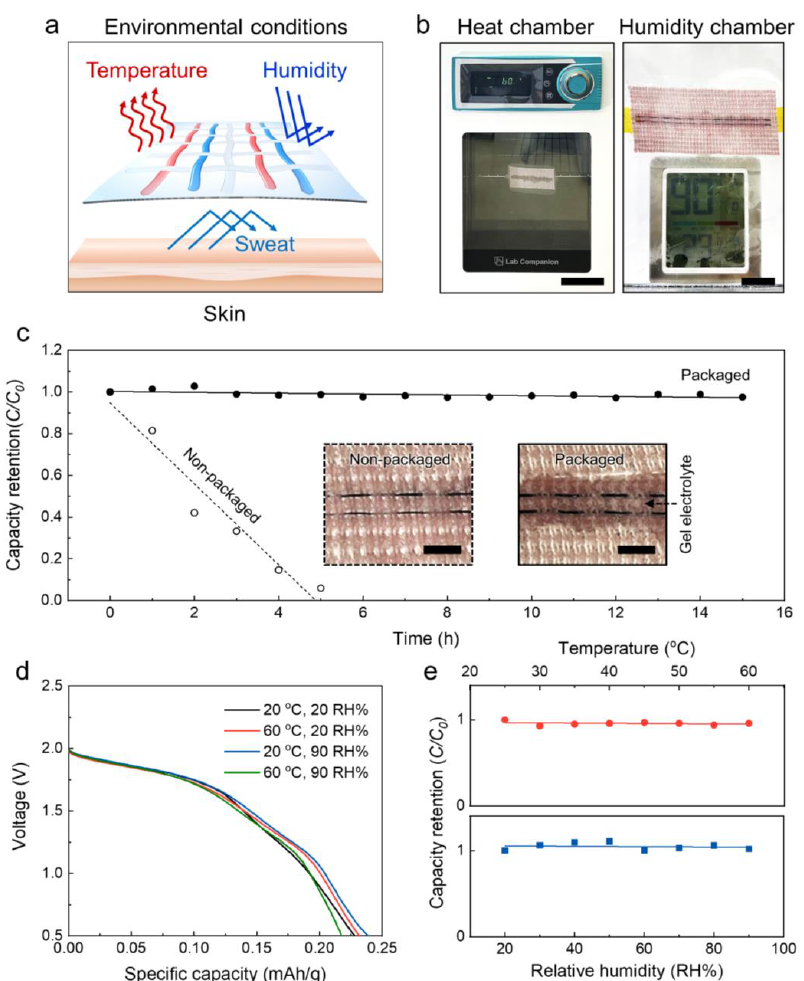
Figure 3. ( a ) Schematic illustration showing the external environmental factors that affect the electrochemical performance of the textile battery. Optical photographs of the ( b ) oven and ( c ) humidity chambers in the experiments (scale bars are 8 and 2 cm, respectively). ( c ) Capacity retention performances of the nonpackaged and packaged textile batteries for 15 h; the inset optical images show the nonpackaged and packaged textile batteries exposed to environmental conditions for 5 h. ( d ) Galvanostatic discharge curves of the packaged textile battery at 20 °C and 20 RH% (black line), 60 °C and 20 RH% (red line), 20 °C and 90 RH% (blue line), and 60 °C and 90 RH% (green line). ( e ) Capacity retention curves versus temperature ( top ) and relative humidity ( bottom ).